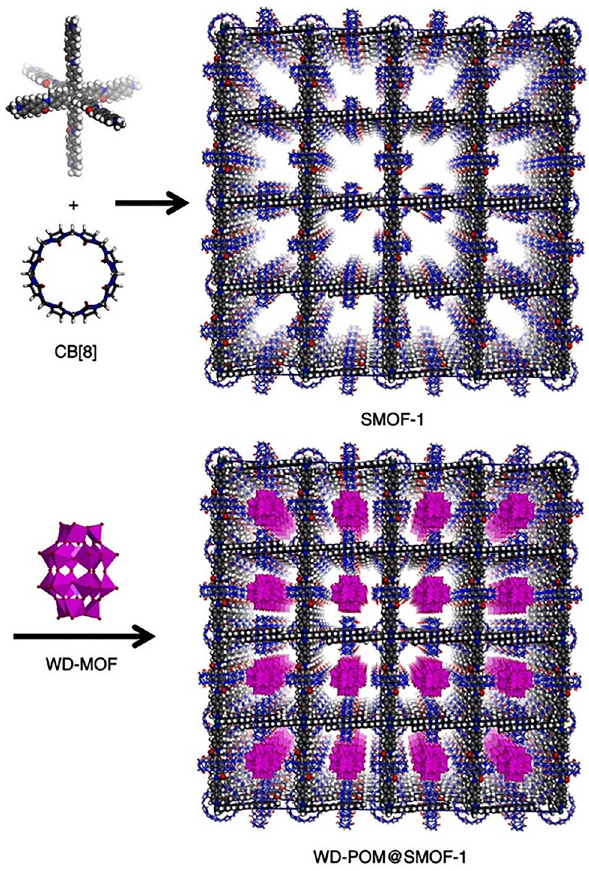
Figure 5: A schematic illustration of POMOF, showing the encapsulation of WD-POM ([P 2 W 18 O 62 ] 6 − purple polyhedra in the cubiccagesofSMOFwhite;C;N,blue;lightgray;O,red;Ru,cyan;for photocatalytic hydrogen evolution. Adopted with permission from ref.